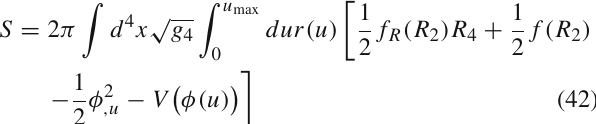
Fig. 7 Time dependence of the perturbations to the solution presented in Fig.3